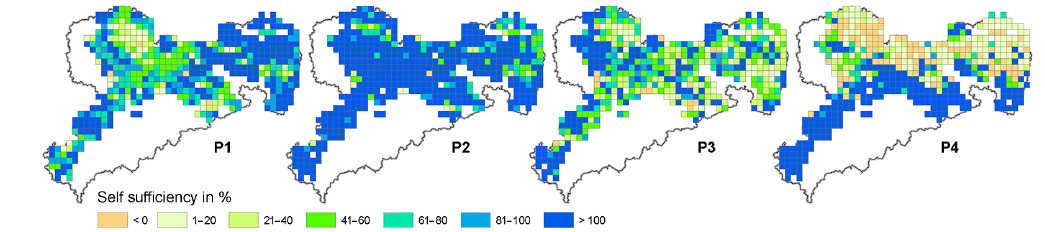
Figure 4. Predicted water self-sufficiency for common bean in relevant regions of Saxony. The water demand results from the same crop yield in all time periods as in P1 with Irrigation = 60mm per year. The available water covers 50% of groundwater recharge plus surface water. All results are averaged over soils in each grid cell and medians of corresponding SCWPF (for details see Wagner et al.,